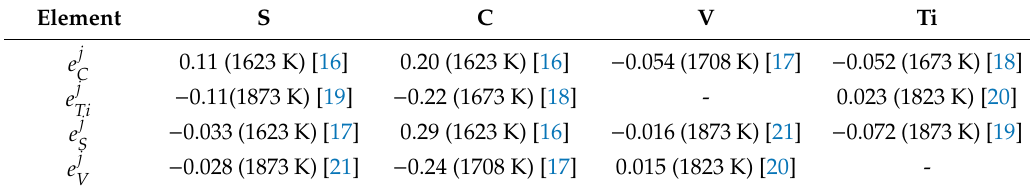
Table 7. Activity interaction coe ffi cient of the main elements.